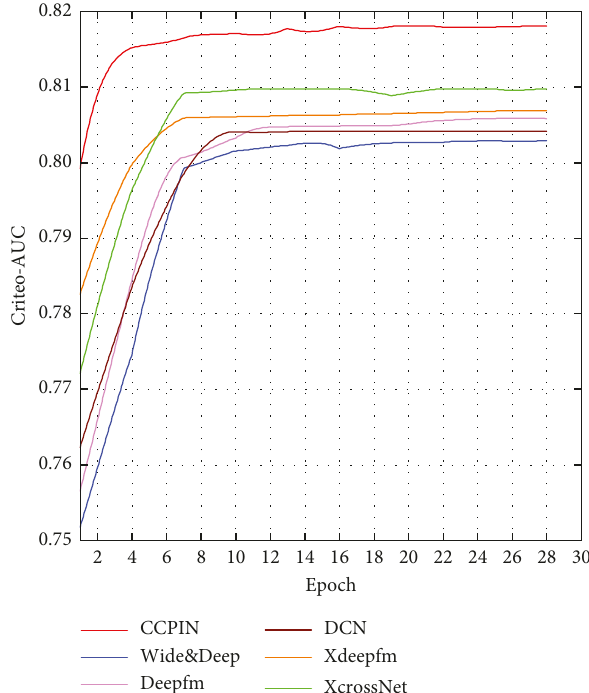
Figure 7: The CTR prediction performance of different models on the Criteo